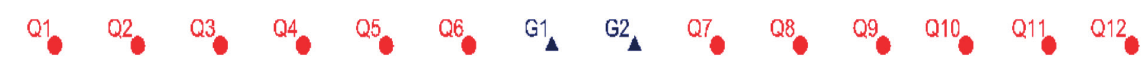
– Longitduinal Axis.